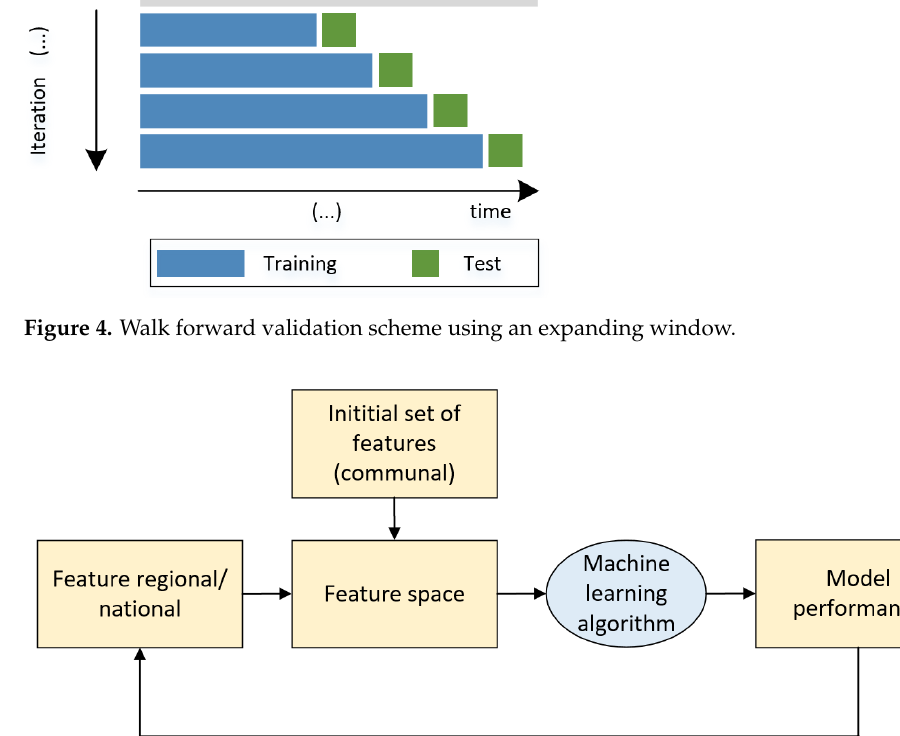
Figure 5. Proposed workflow to determine the relevance of the